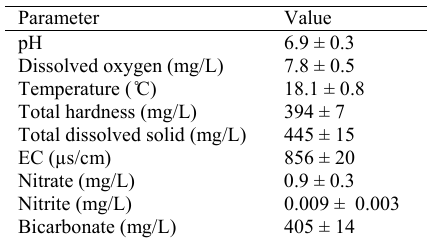
Table 1: Characteristics of groundwater used for the experiment Parameter